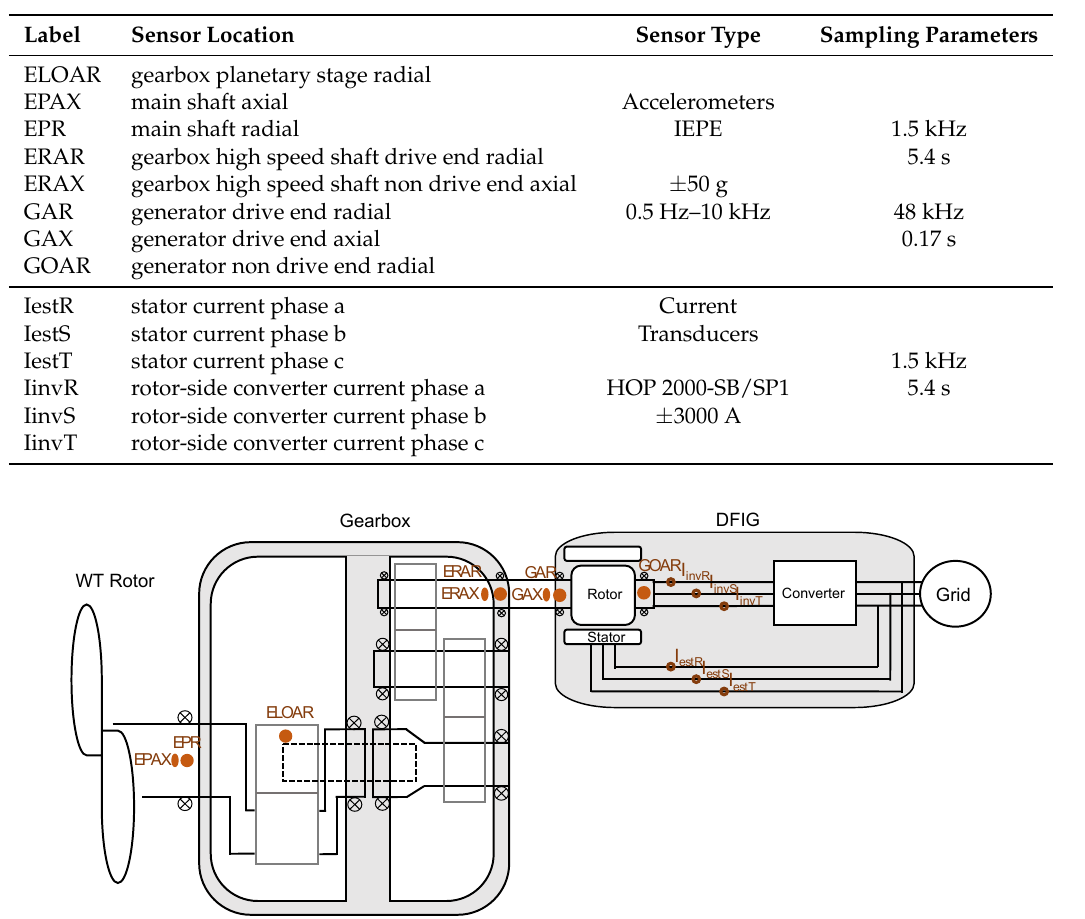
Table 1. Measurements used for the analysis.